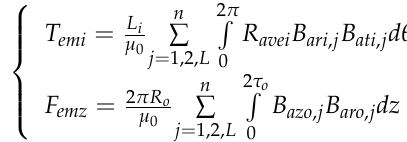
Table 1. Parameters of the DSLRPMM.